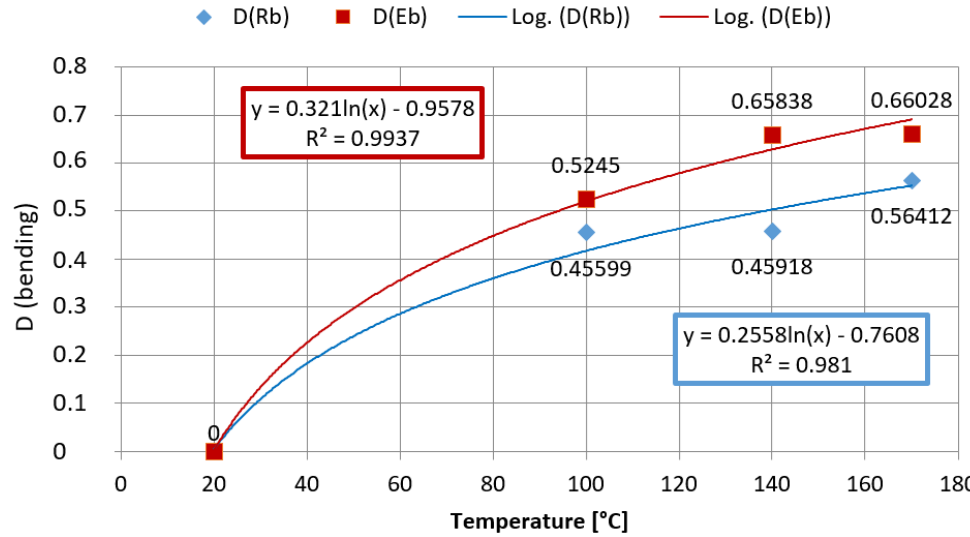
Figure 13. Results of testing the level of damage of strength and stiffness of the PA66 composite reinforced with glass fiber at fire temperature values: bending test.